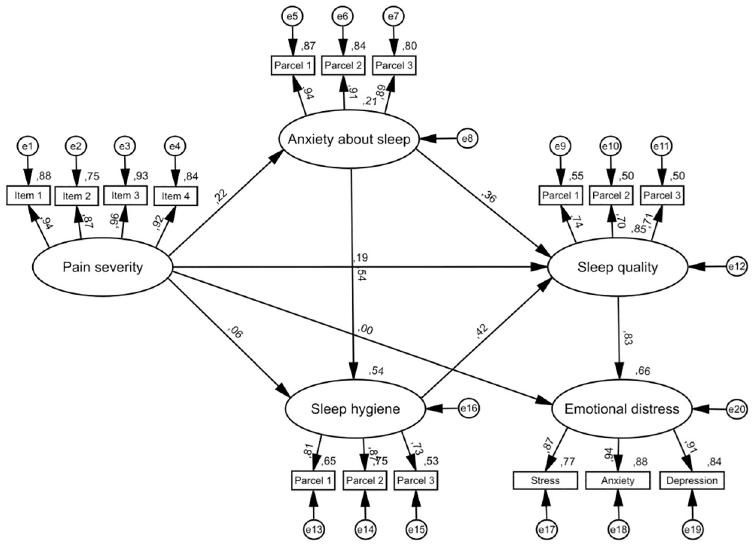
Fig 3. Model 3—Pathways linking pain severity, sleep quality and emotional distress. N = 468. Rectangles represent observed variables and ovals represent latent variables. All values are standardized coefficients, except for values near variables, which are squared multiple correlations. Error terms of variables are depicted as e1-e20. Control variables (age, gender, ethnicity, employment and marital status, educational level, perceived health, taking sleep medications, taking non-sleep medications and history of sleep disorders) are not depicted to support visual clarity. For sleep quality and sleep hygiene higher scores indicate poorer sleep quality/sleep hygiene.